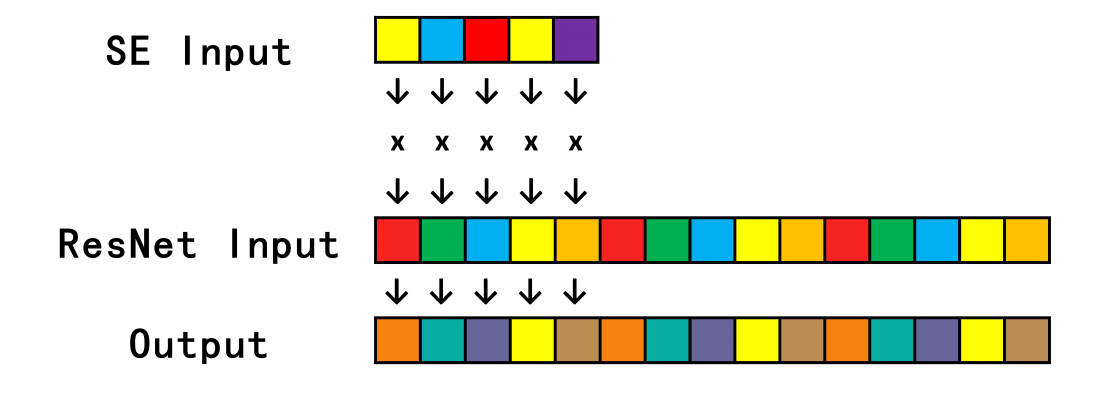
Figure 10. Stream Mul process.